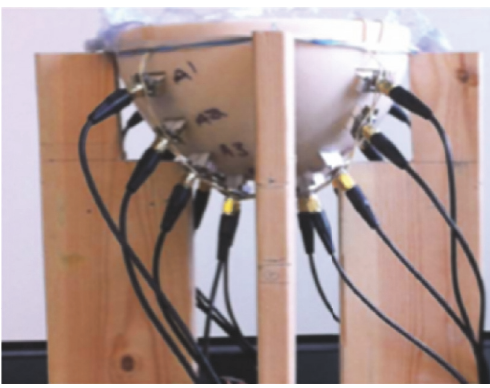
Figure 25: Antenna array at McGill University [29]. Image copyright IEEE, used with